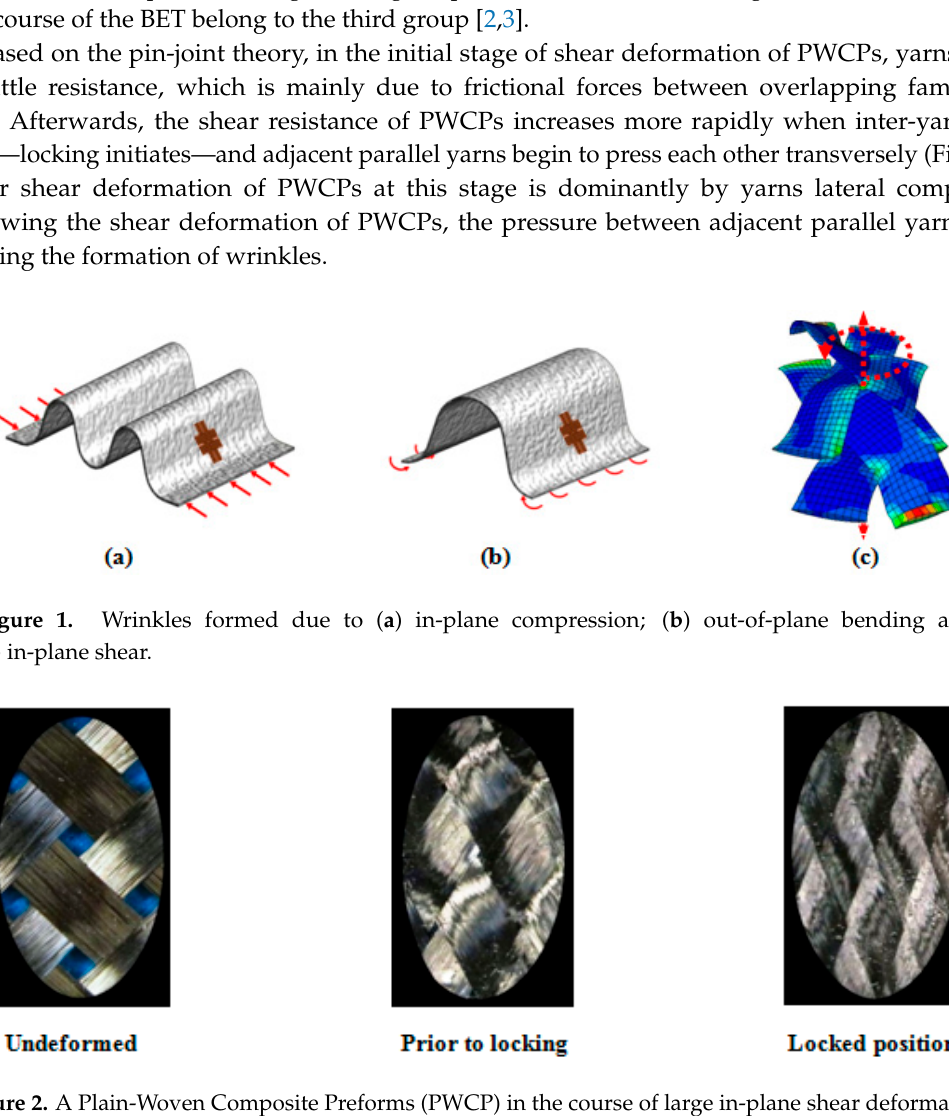
Figure 2. A Plain-Woven Composite Preforms (PWCP) in the course of large in-plane shear deformation.